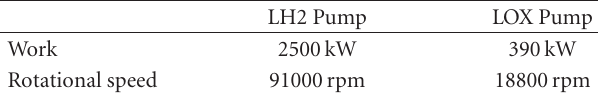
Table 1: Requirements of LH2/LOX pumps. LH2 Pump LOX